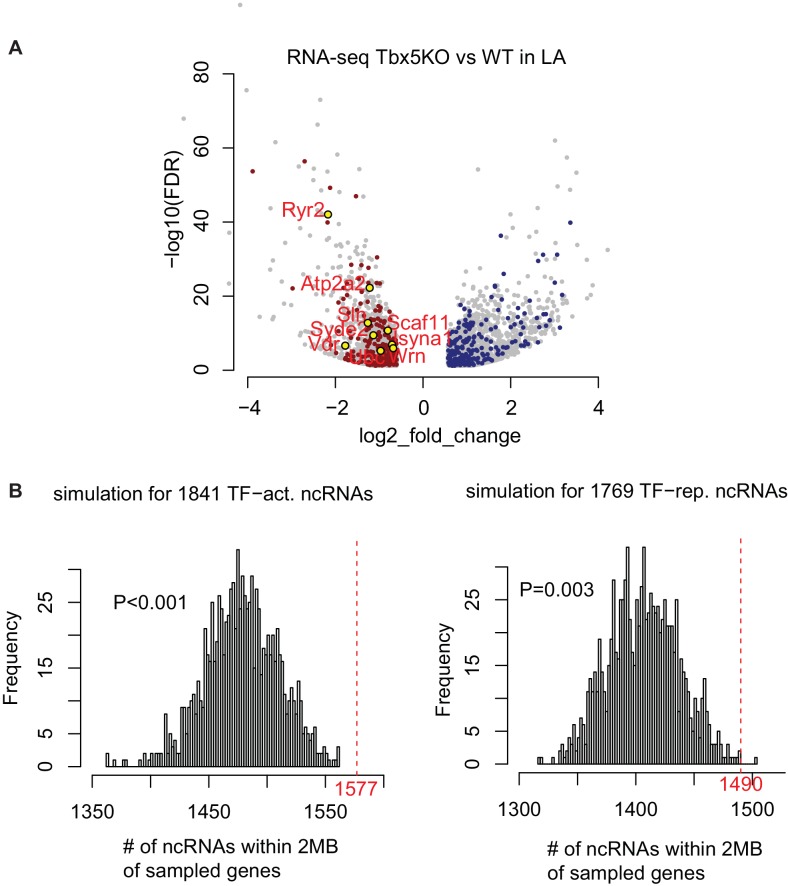
Identifying TF-dependent ncRNA targets from TF-dependent expressed genes.(A) TF-dependent genes are coherent with TF-dependent ncRNAs. Volcano-plot of TF-dependent genes (FDR < 0.05, |FC| > 1.5). Genes residing within 2 Mb of coherently TBX5-dependent ncRNAs are colored red for Tbx5-activated, blue for Tbx5-repressed ncRNAs. (B) Simulation study shows the empirical significance of Tbx5-dependent ncRNAs within a 2-Mb window of Tbx5-dependent coding-genes. The histograms show the distribution of randomly sampled ncRNAs within 2 Mb window of randomly sampled genes. The red dashed line showing the observed number iof Tbx5-activated or Tbx5-repressed ncRNAs, respectively. An empirical P-value was calculated.